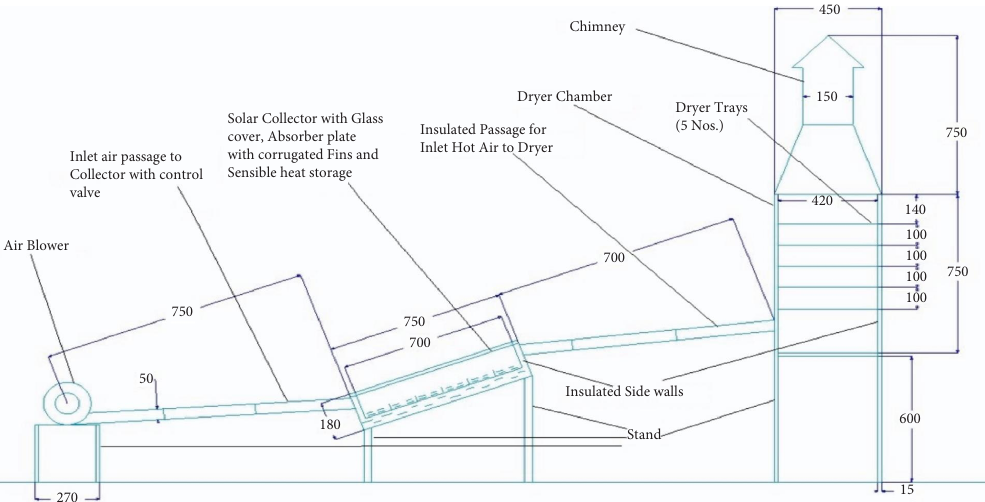
Figure 2: Schematic diagram of the complete experimental setup with the integrated composite dryer